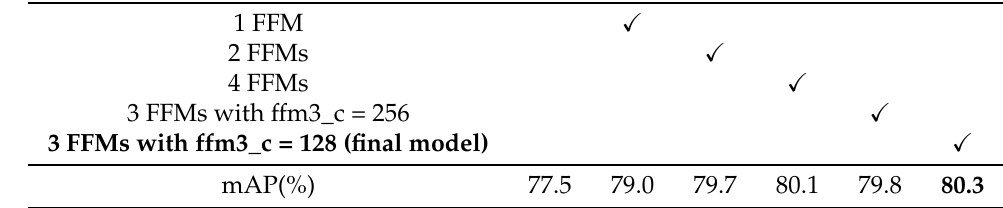
Table 5. Ablation study on VOC 2007 test . In the table, ffm3_c indicates the channel number of third feature fusion module.